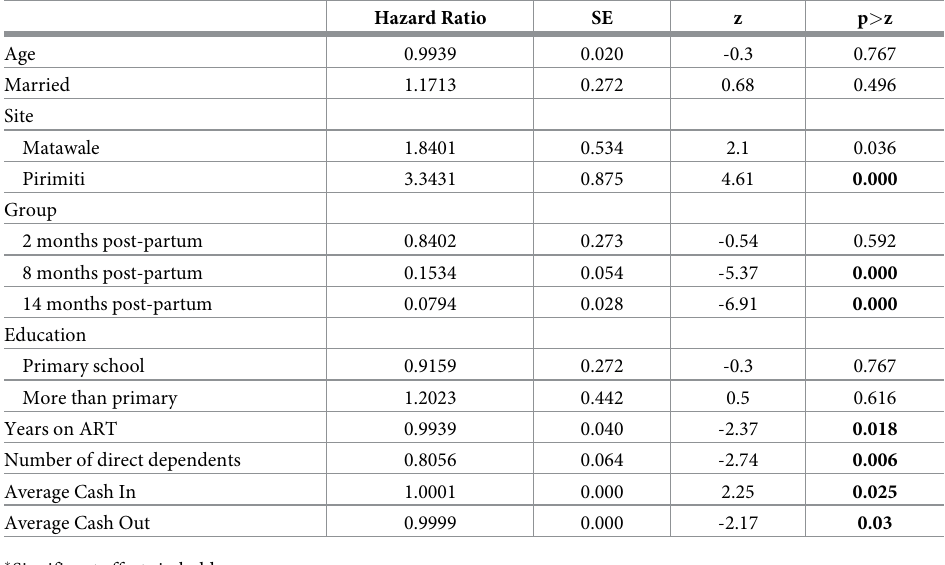
Table 7. Cox proportional hazard